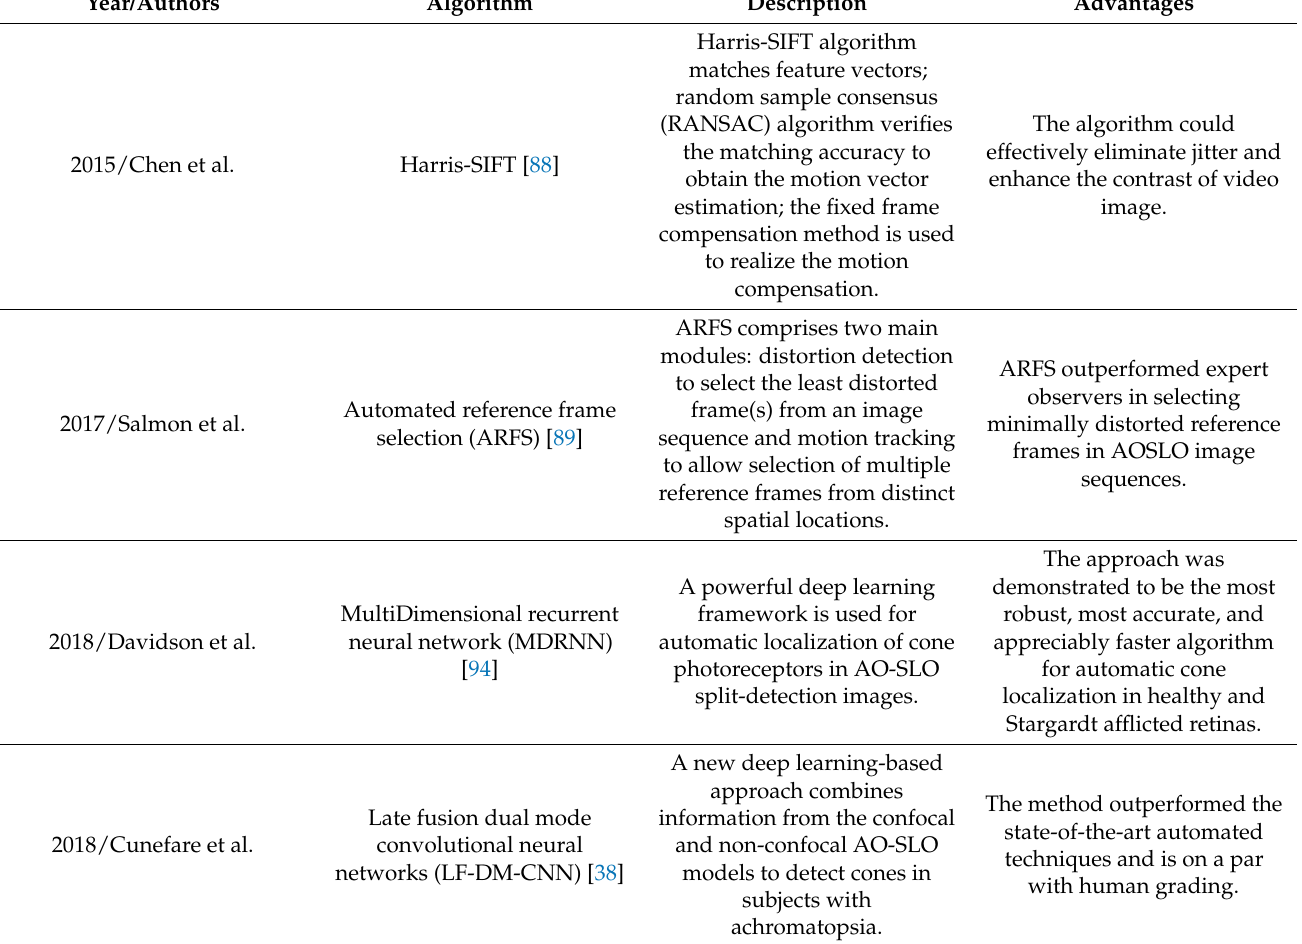
Table 1. Algorithms for improving system